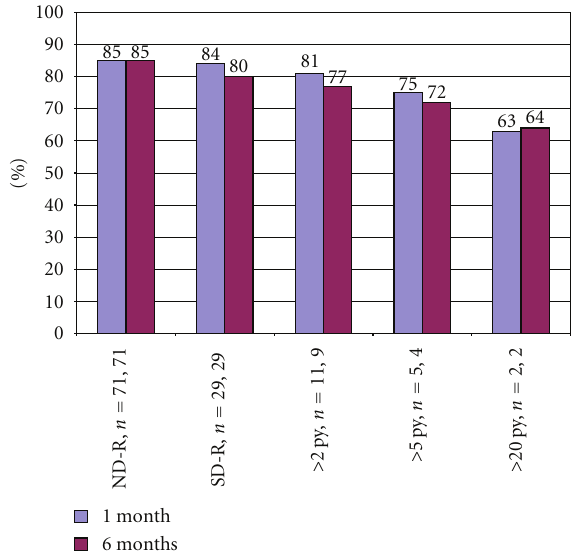
Figure 2: Comparison of percent decrease in creatinine (Cr) at 1 and 6 months between the recipients of renal allografts from living donors who have a history of tobacco use (SD-R) and donors with no history of tobacco use (ND-R) stratified by donor smoking exposure in pack-years (py).